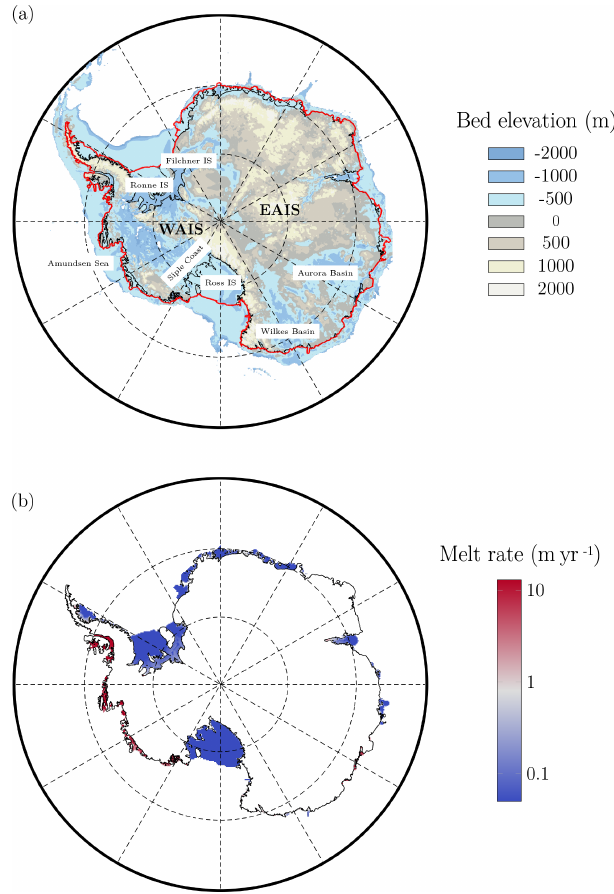
Figure 1. Antarctic bedrock topography and sub-shelf melting. (a) Bedrock topography (ma.s.l.) (Fretwell et al., 2013) of the present-day Antarctic ice sheet and geographic features. WAIS is the West Antarctic ice sheet, EAIS is the East Antarctic ice sheet and IS is ice shelf. Grounding line is shown in black and ice front is shown in red. (b) Sub-shelf melt rate for the present-day Antarc- tic ice sheet computed with the PICO ocean model (Reese et al., 2018a). Refreezing under ice shelves is not